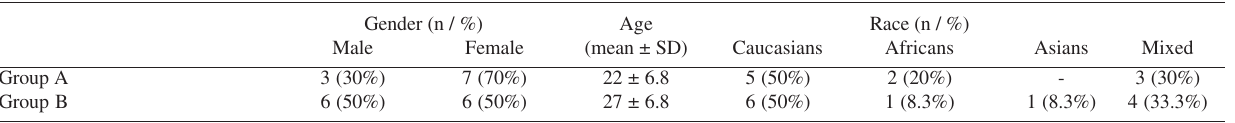
Table 1 - Demographic data for groups A and B